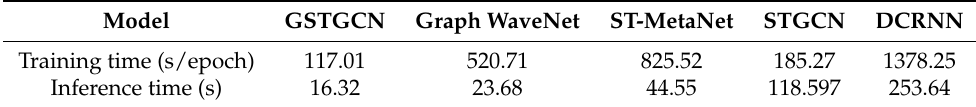
Table 4. The computation time on the PeMSD7